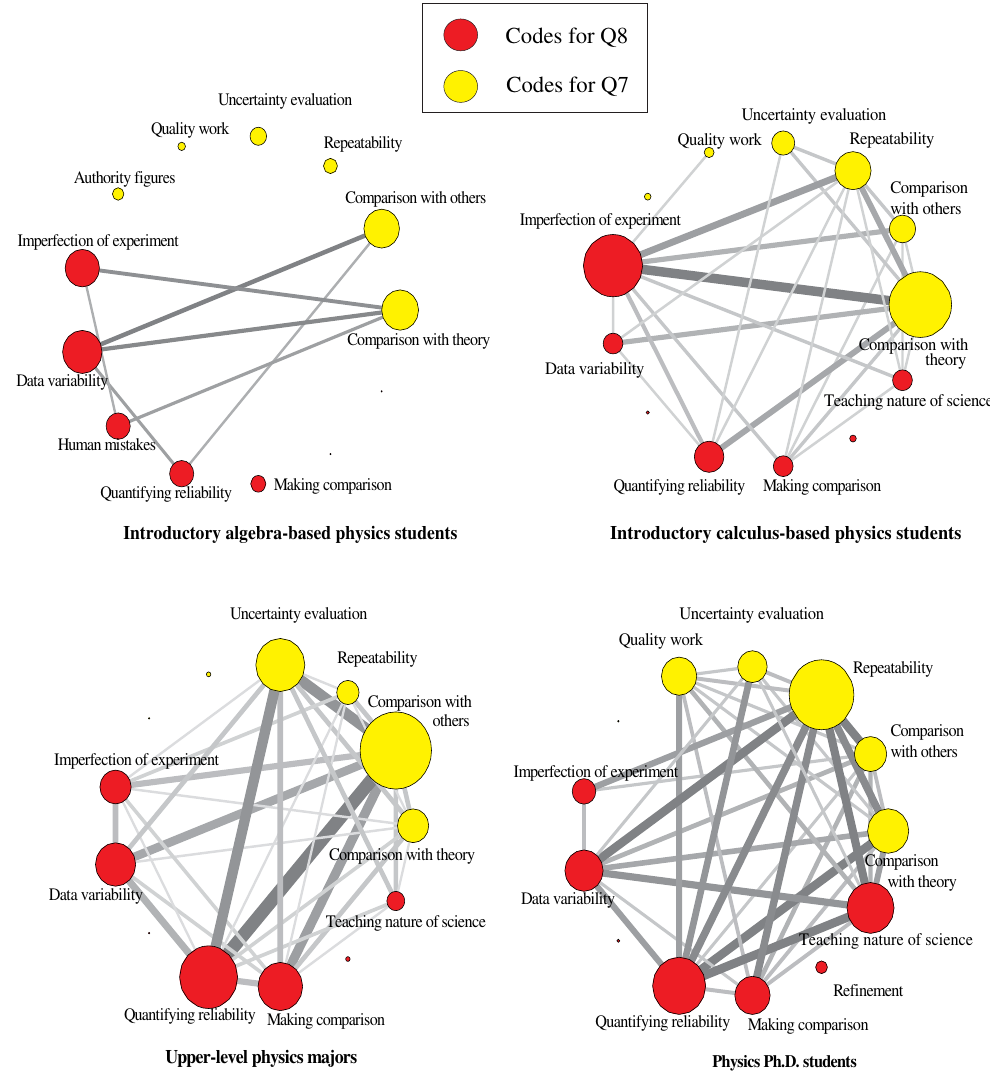
FIG. 4. Network analysis [Red circle represents codes for Q8, and yellow circle represents codes for Q7. The size of each circle is proportional to the percentage of responses (i.e., the frequency of code divided by the size of the subpopulation). The thickness of the edges is also normalized and proportional to the percentage of weights of edges (i.e., frequency of connections divided by the total number in that population). In each of the network plots, the gray scales of edges vary linearly depending on the weights, and darker lines correspond to greater